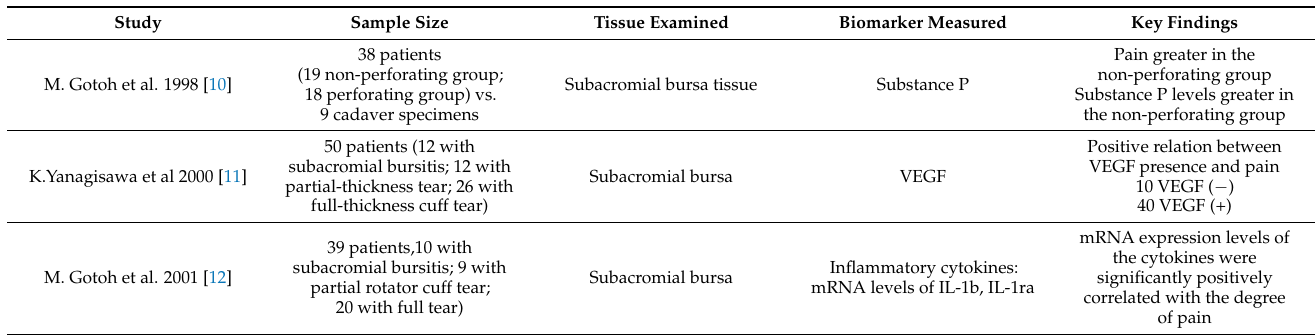
Figure 1. PRISMA flow diagram of this scoping review. * Two stage search was conducted in order to identify specific biomolecules related to rotator cuff related pain. Table 2. Human studies directly investigating biomolecules in patients suffering from pain due to rotator cuff